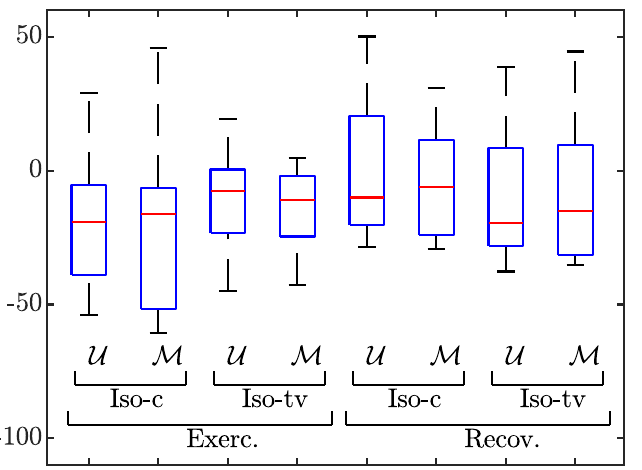
Fig 6. Distributions of the differences Λ τ = τ φ , s − τ φ , p , φ 2 { e , r }, between the QT adaptation delays calculated in , and the corresponding QT adaptation delays from the patients, τ the simulations, τ φ , s (Iso-c) and time-varying (Iso-tv) β -adrenegic stimulation, for exercise (four most-left boxplots) and recovery (four most-right boxplots).